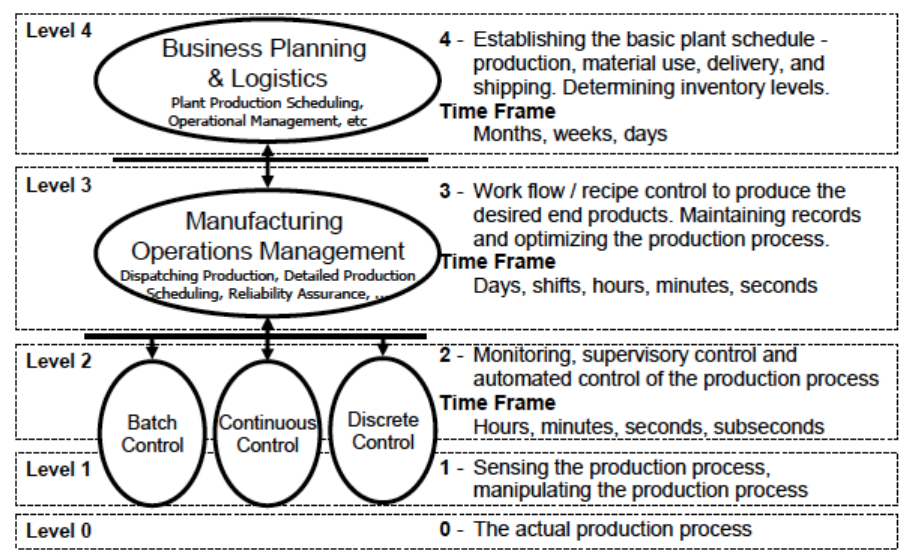
Figure 1. The automation pyramid